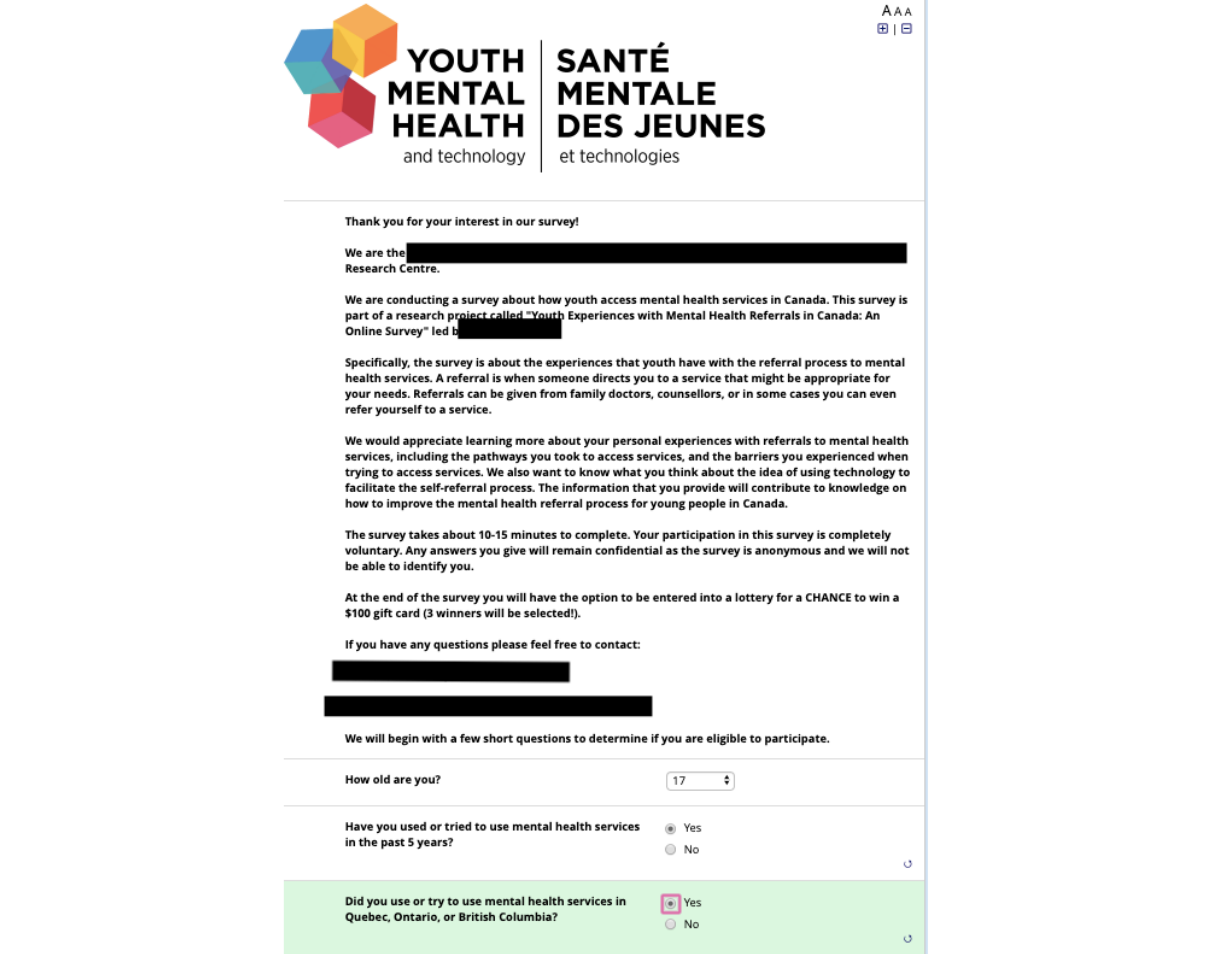
Figure 1. Questionnaire introduction and screening